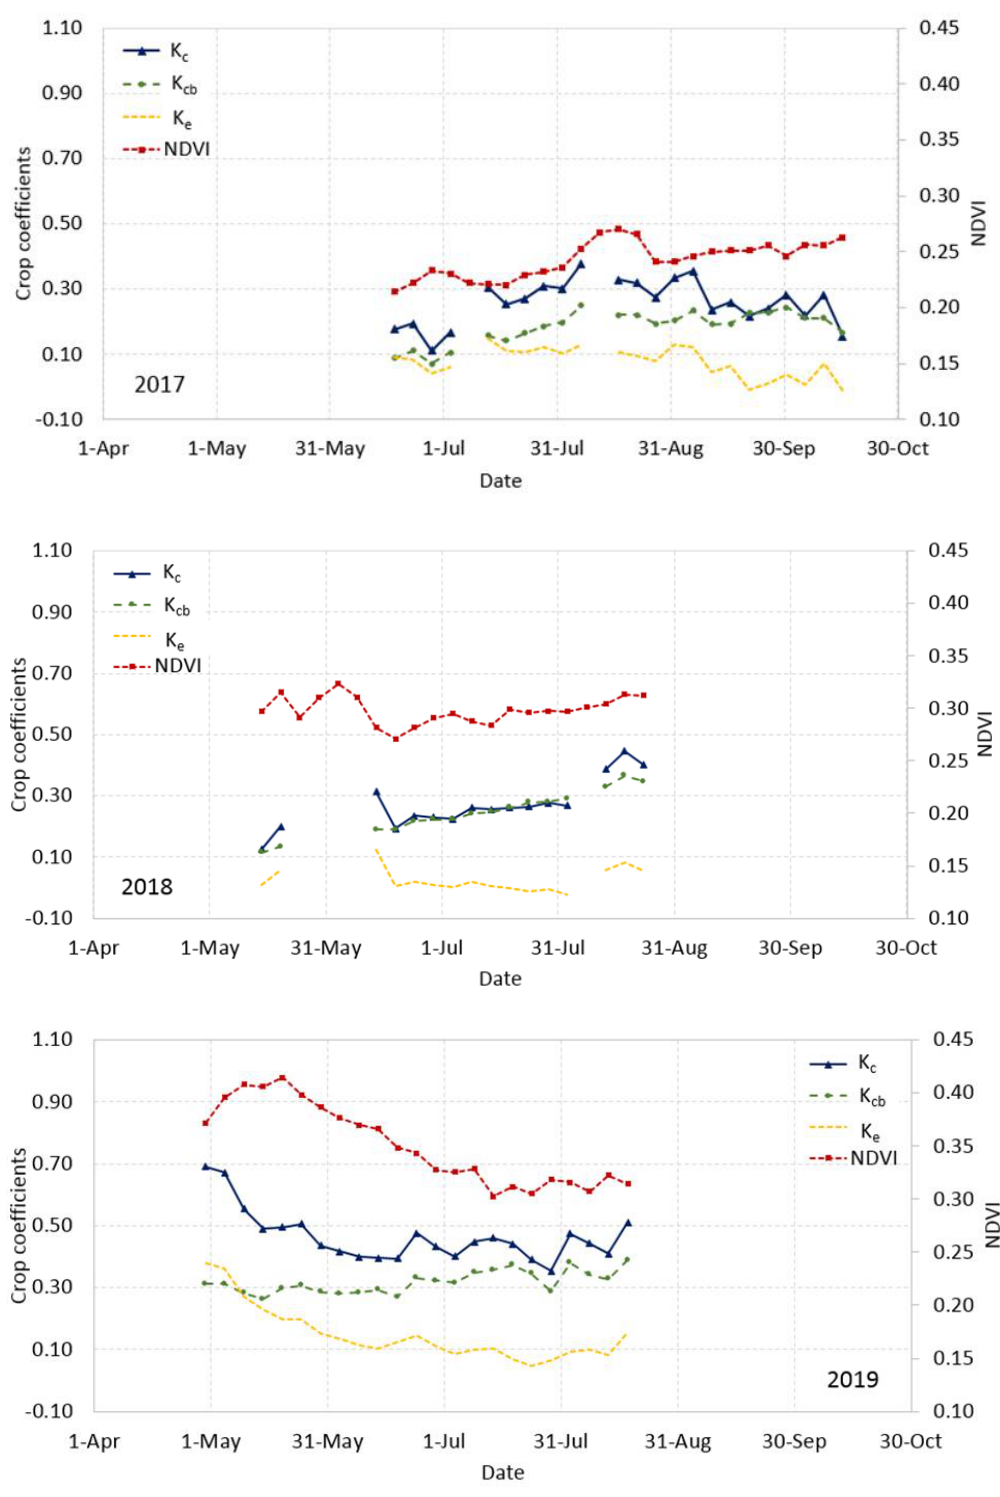
Figure 10. Evolution of the crop coefficients estimated from the modeled ET c (K c ), T (K cb ), and E (K e ) for the 2017–2019 growing seasons. NDVI values are also superposed. All data correspond to 5-day averages. Dates affected by rain events >5 mm were discarded from this analysis.